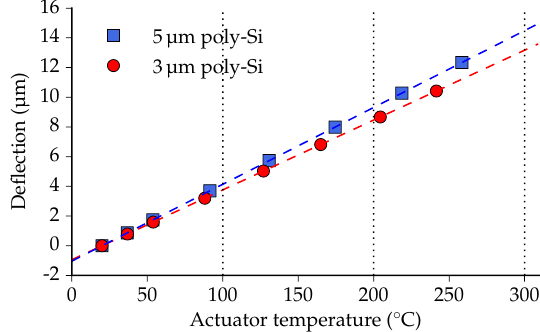
Figure 14. The vertical deflection as a function of the estimated actuator temperature. The dashed lines represent linear functions fitted to the data points. As a visual guide, 100 ◦ C, 200 ◦ C and 300 ◦ C are indicated by dotted lines.